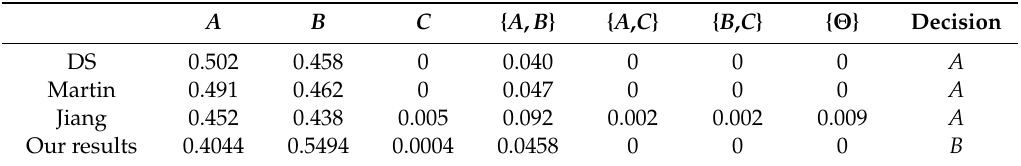
Table 4. Combination results of the evidence m 1 , m 2 and m 3